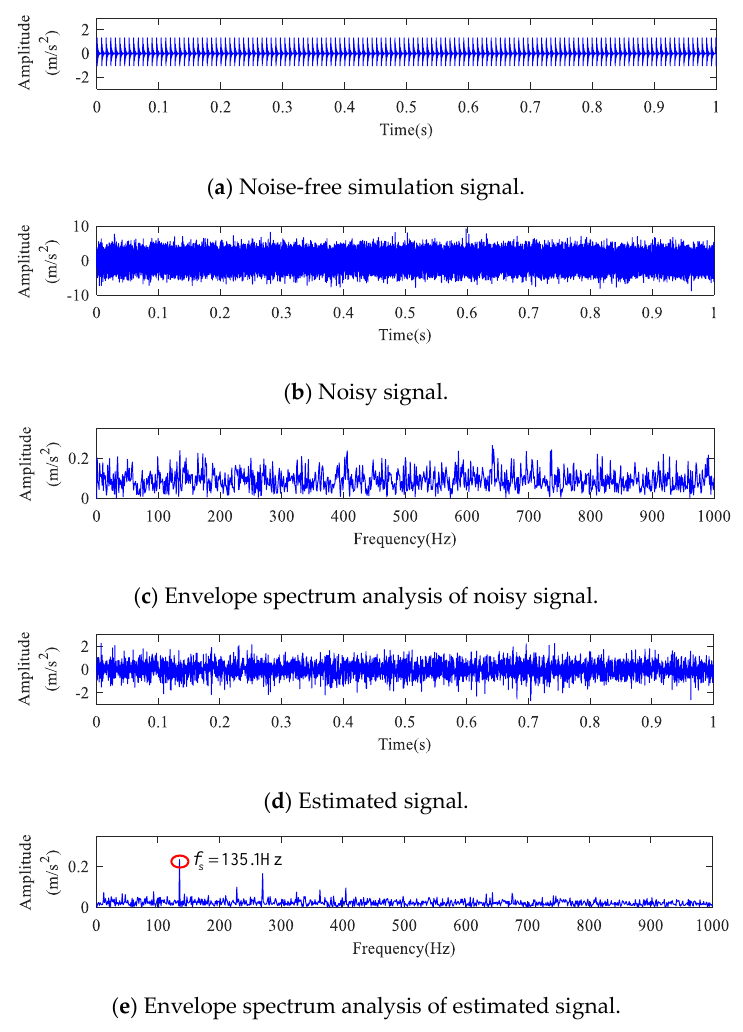
Figure 2. Results of simulated signal.